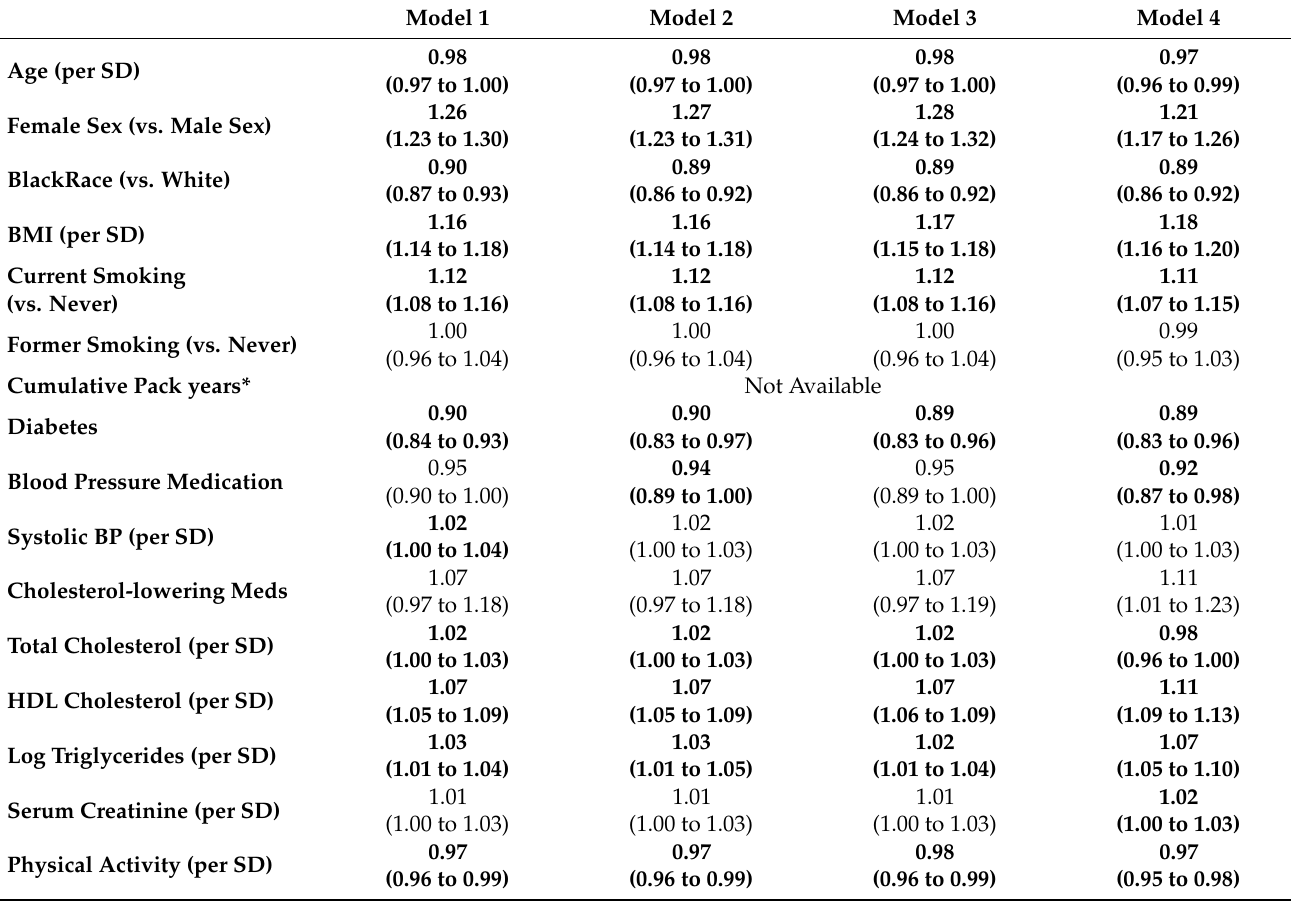
Table 4. Adjusted associations between Plasma IsoP vs. cardiovascular risk